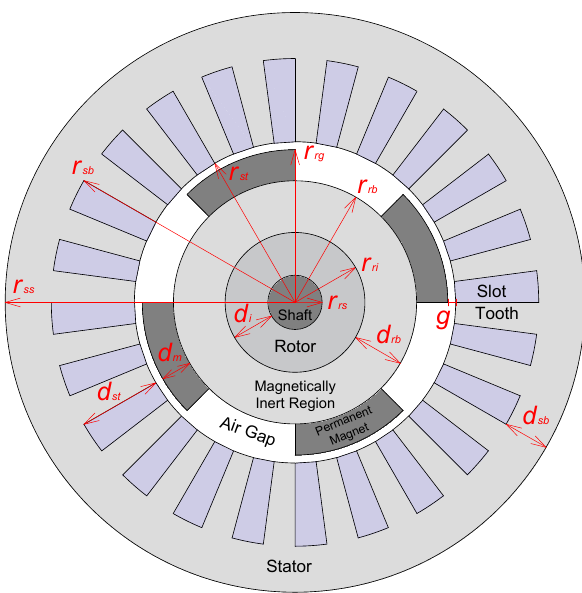
Figure 1. Cross-section of the Permanent Magnet Synchronous Machine